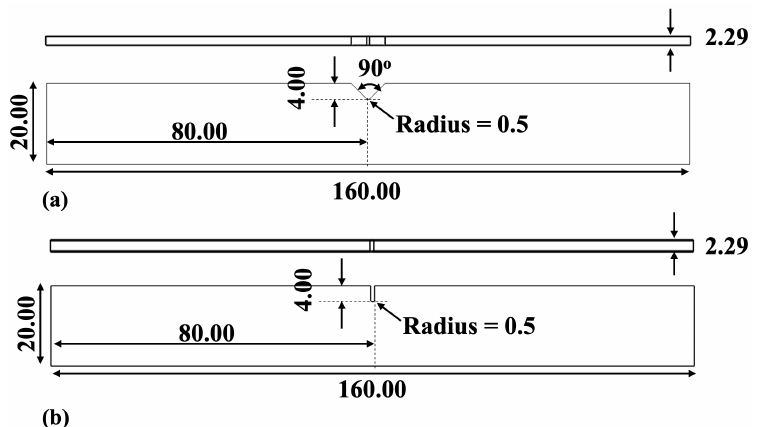
Figure 2. Specimen designs for ( a ) K t 1 and ( b ) K t 2 (all dimensions are in mm).